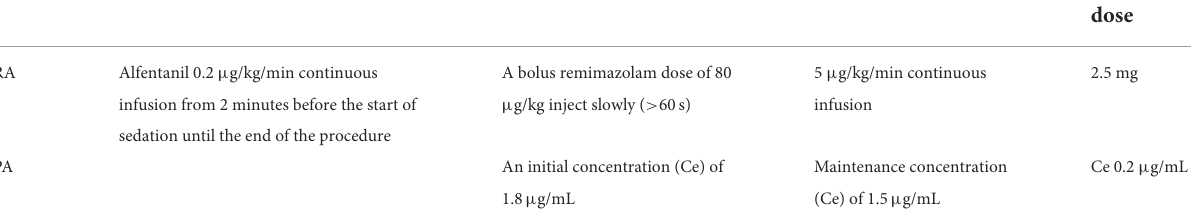
TABLE 1 Sedation protocol in the two groups. Group Analgesic dose